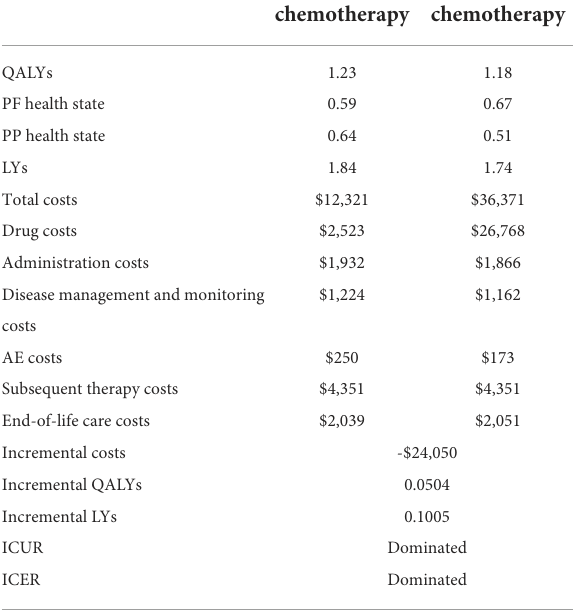
TABLE 6 The results of scenario